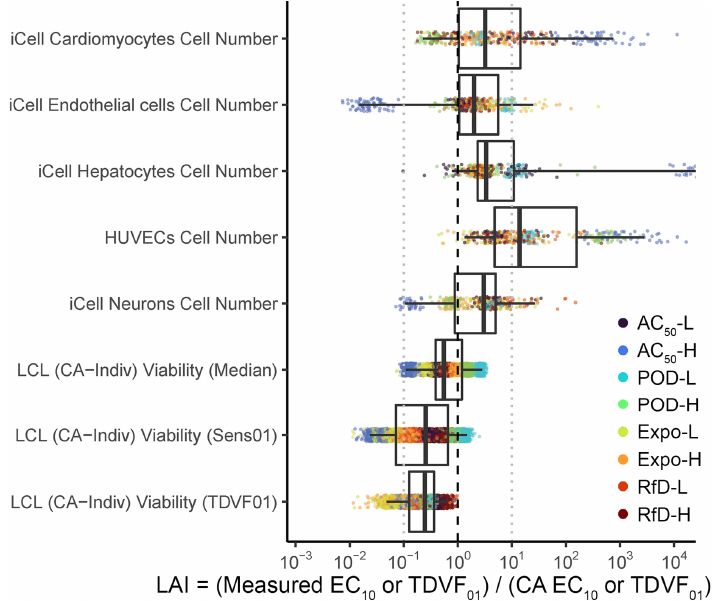
Figure 6. Comparison of Loewe Additivity Index (LAI) across cell types for cytotoxicity phenotypes. iCell and HUVEC results are from [30] ; LCL results are those for CA Indiv from the present analysis of data reported in [47] . LAI < 1 indicates greater-than-additive effects (“synergy”) and LAI > 1 indicates less-than-additive effects (“antagonism”). In both panels, dashed line indicates equality, and light dotted lines indicates 10-fold differences in either direction. Results for phenotypes from [30] and other CA methods from the present analysis are shown in Supplementary Figure S1. Table 1. Summary statistics of Loewe Additivity Index (LAI, median posterior estimate, and 95% CI) across cell types for cytotoxicity phenotypes.